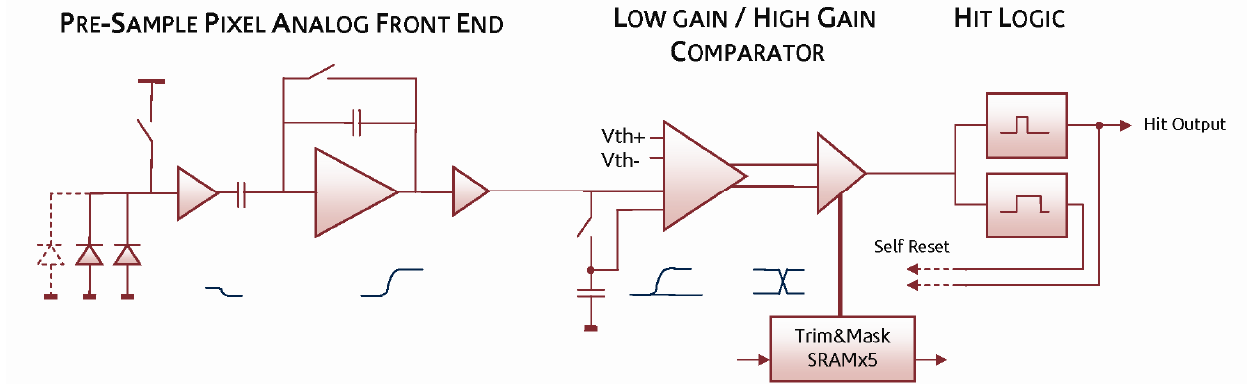
Figure 4. PreSample pixel block diagram showing the analogue signal path from collecting diodes to binary hit